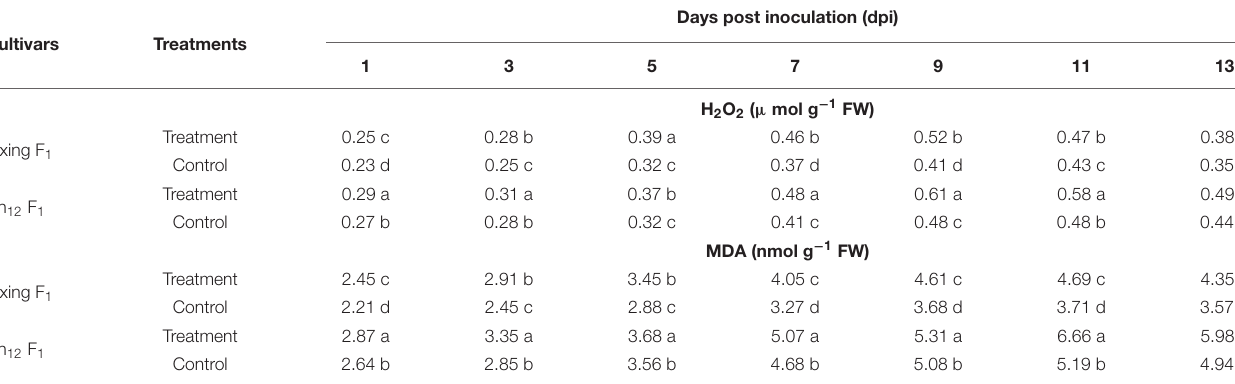
TABLE 5 | H 2 O 2 and MDA content in different cultivars of Cucurbita pepo seedlings after inoculation with Podosphaera xanthii.